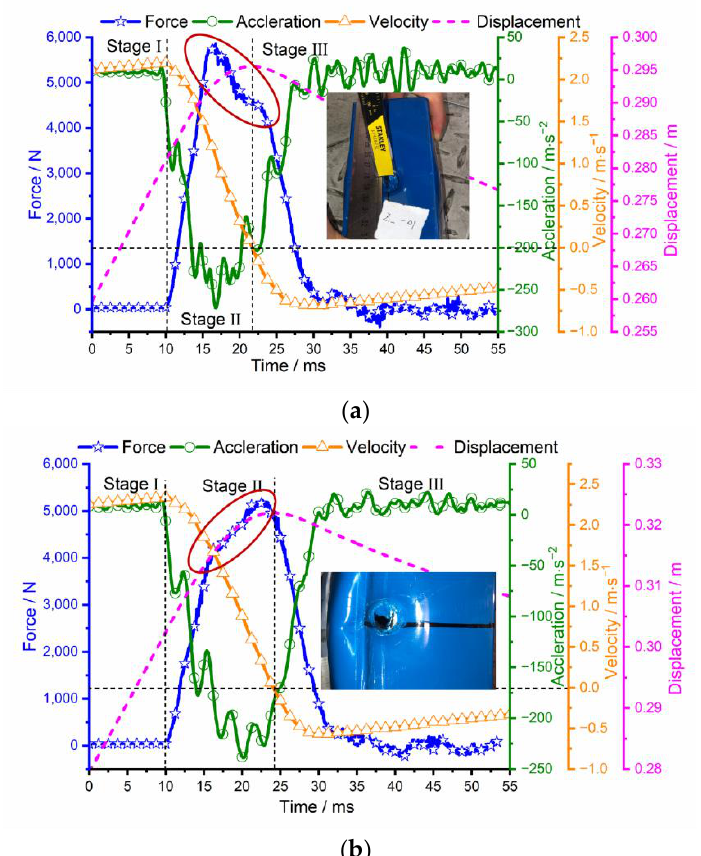
Figure 7. Drop- weight test results of the battery at Z− positions. ( a ) Test results at Z3− position; ( b ) Figure 7. Drop-weight test results of the battery at Z − positions. ( a ) Test results at Z3 − position; ( b ) Test results at Z4− position. Test results at Z4 − position.